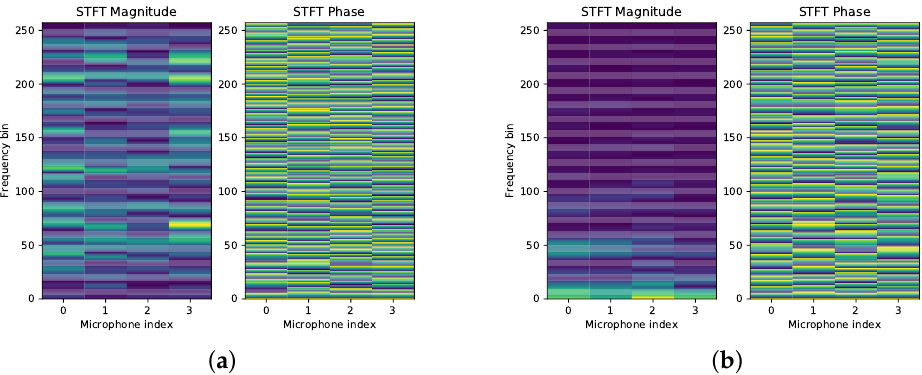
Figure 1. Examples of STFT input features: STFT magnitude and phase of a training sample (( a ) noise signal; ( b ) speech